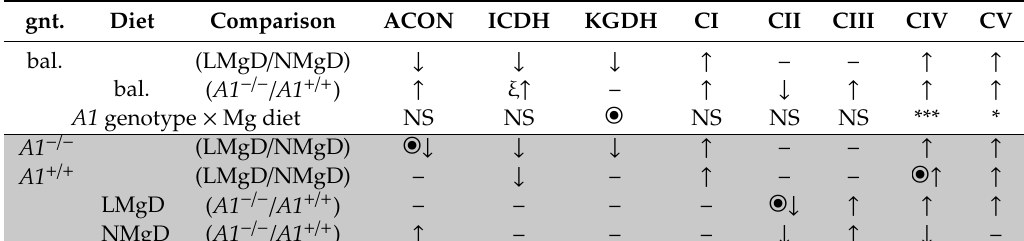
Table 1. Brief data